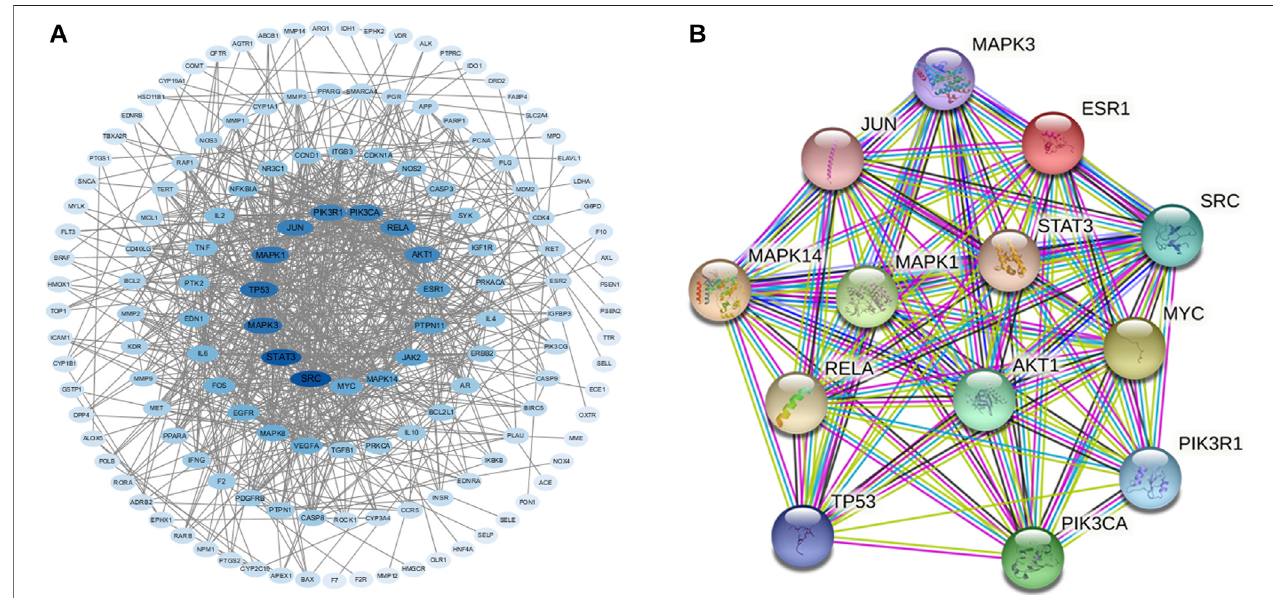
FIGURE 2 | (A) PPI network of intersection protein targets. The size and color of the targets are based on the degree value. The larger and deeper the node is, the more important the target is. (B) PPI network of 13 core genes.